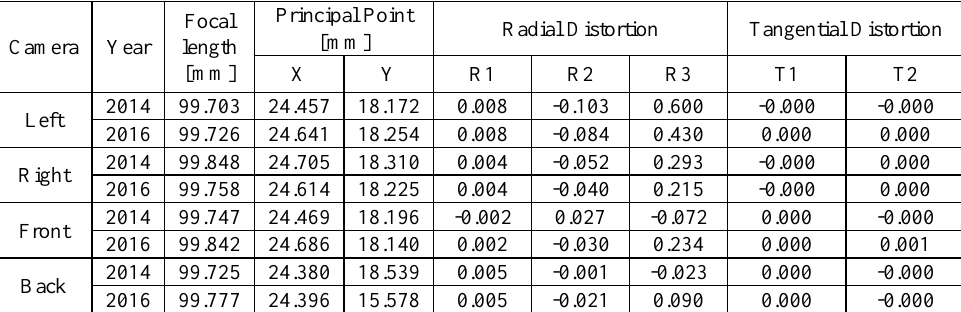
Table 2. Interior orientation parameters estimated during selfcalibration in